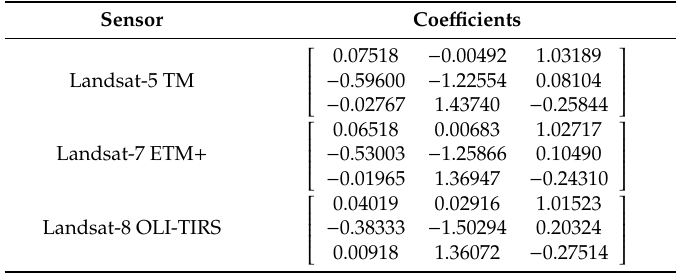
Table A1. Coe ffi cients in matrix notation used to calculate the AFs in combination with water vapor contents. Coe ffi cients are taken from [57,58].